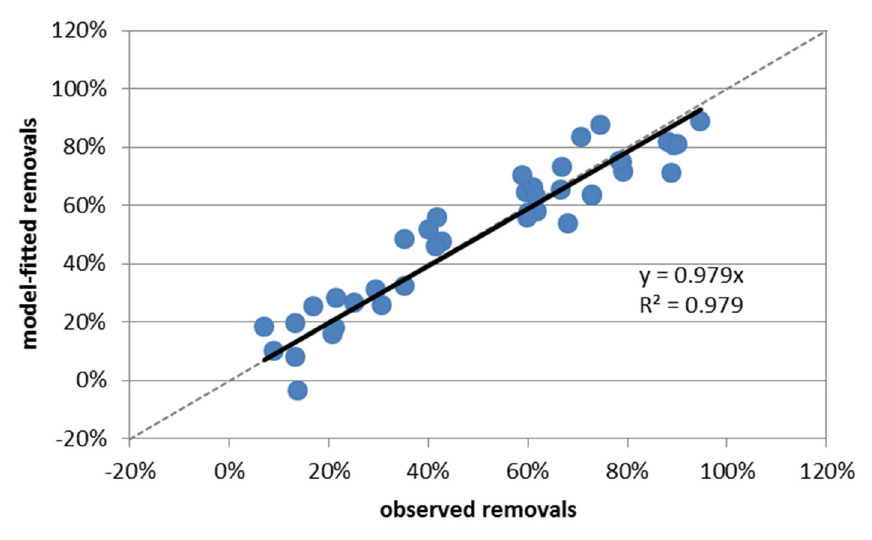
Figure 3. Observed removals versus model-fitted removals (nine parameters model, 21 h batch adsorption).